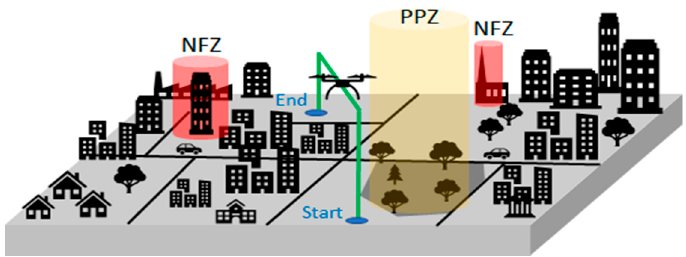
Figure 13. Schematic of simple drone trip from start to end point—no conflict detected.